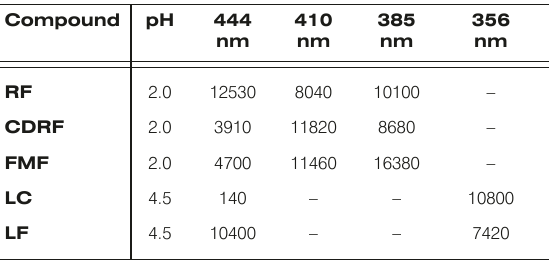
Table 1. Molar absorptivities (M –1 cm –1 ) of RF and photoproducts [7].